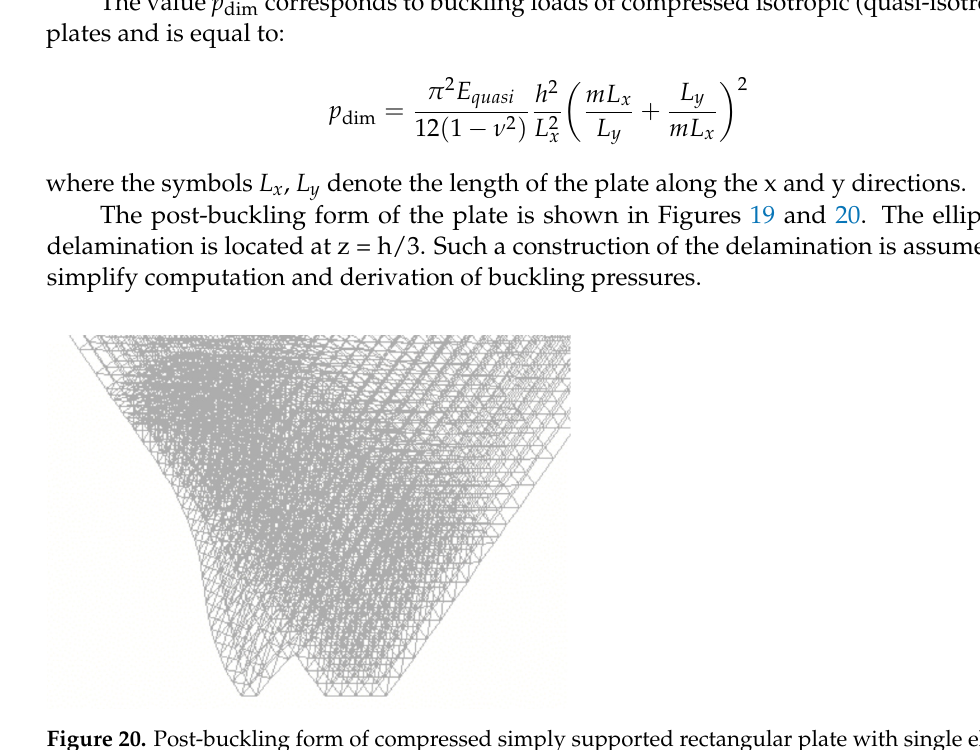
Figure 20. Post-buckling form of compressed simply supported rectangular plate with single elliptical delamination.